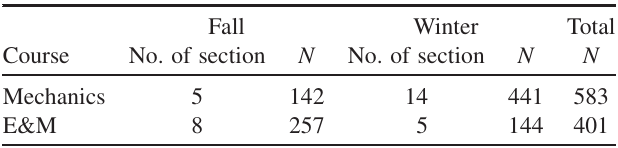
TABLE I. Study population for fall and winter divided by course. In the fall, the primary course is E&M, and in the winter, the primary course is Mechanics.